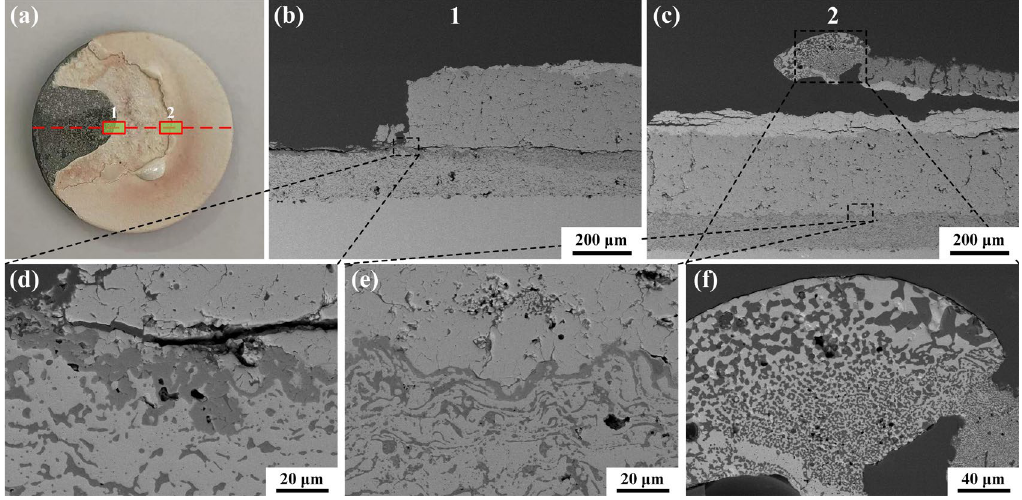
Figure 10. ( a ) Macroscopic and ( b – f ) cross-sectional morphologies of AGAP-GZ-YSZ coating after thermal shock test.